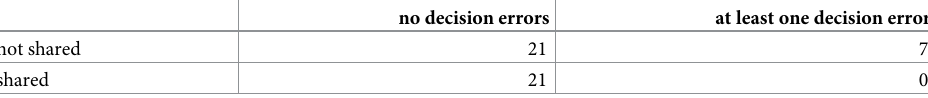
Table 3. Data sharing and presence of decision errors per